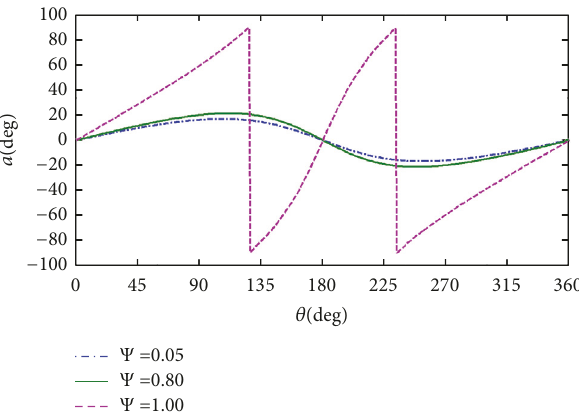
Ψ =0.05 Ψ = 0.80 Figure 6: Angle of attack versus azimuth for different rotation friction ratios, at Re =6.82 × 10 5 .